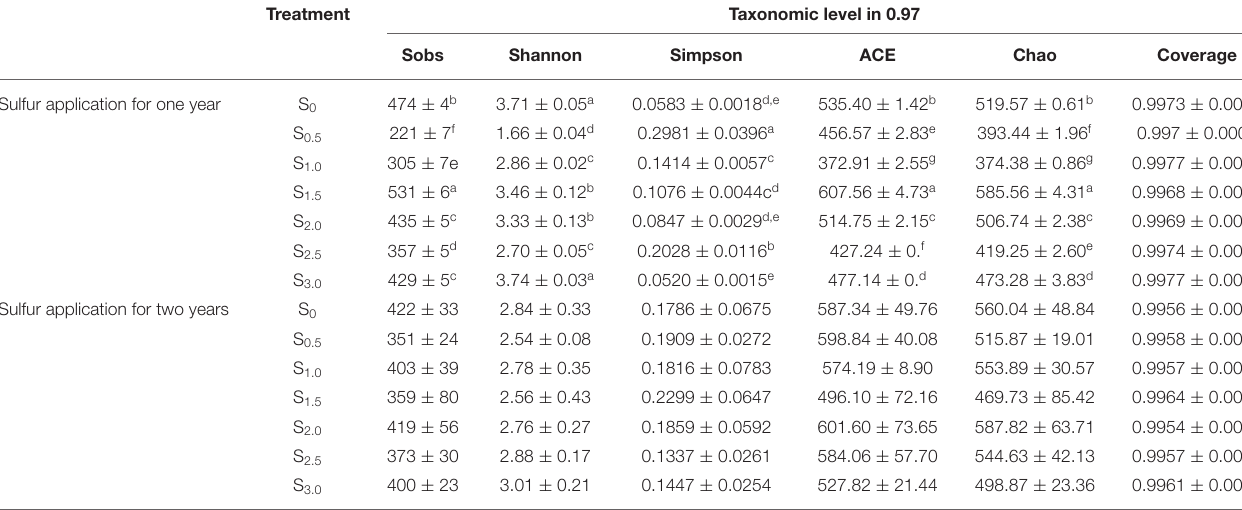
TABLE 4 | Sequence statistics and diversity indexes of sulfur on kiwifruit rhizosphere soil